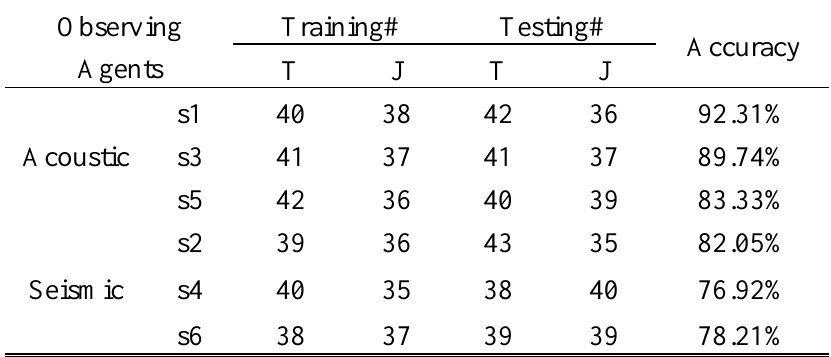
Table 1. Local learning with acoustic and seismic